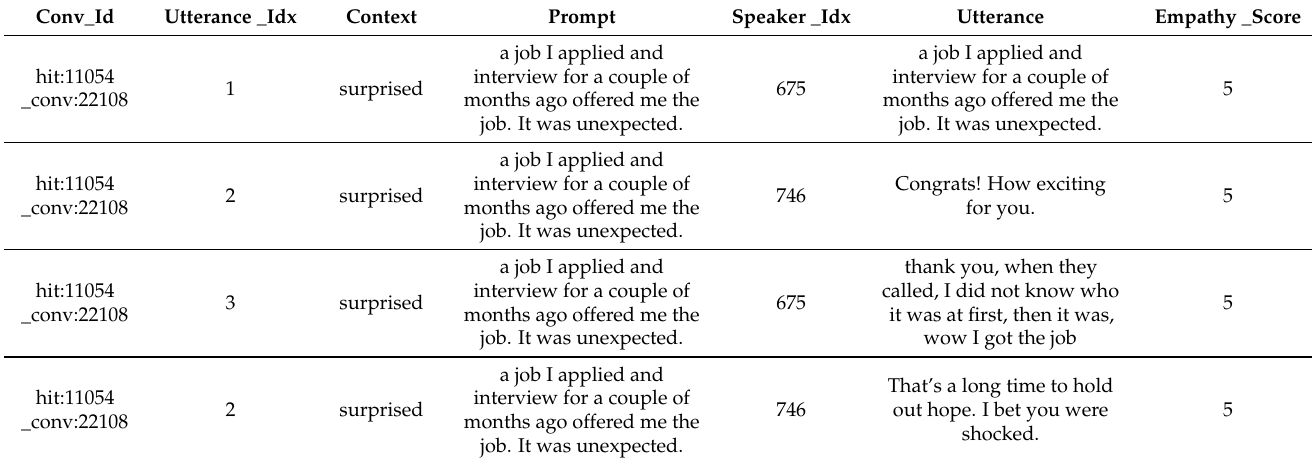
Table 3. Example of a conversation in